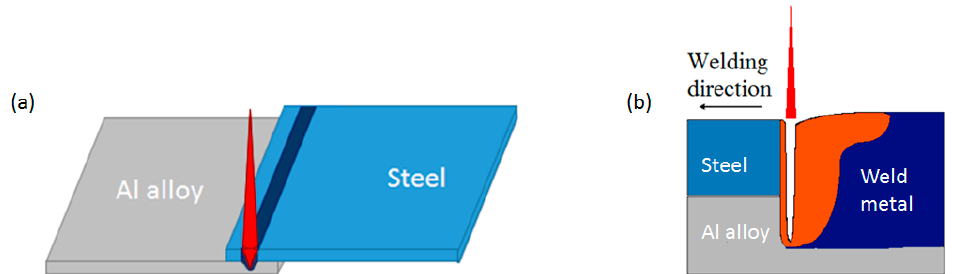
Figure 8. Laser welding with the keyhole mode: general view ( a ) and cross-section detail of the keyhole ( b ).